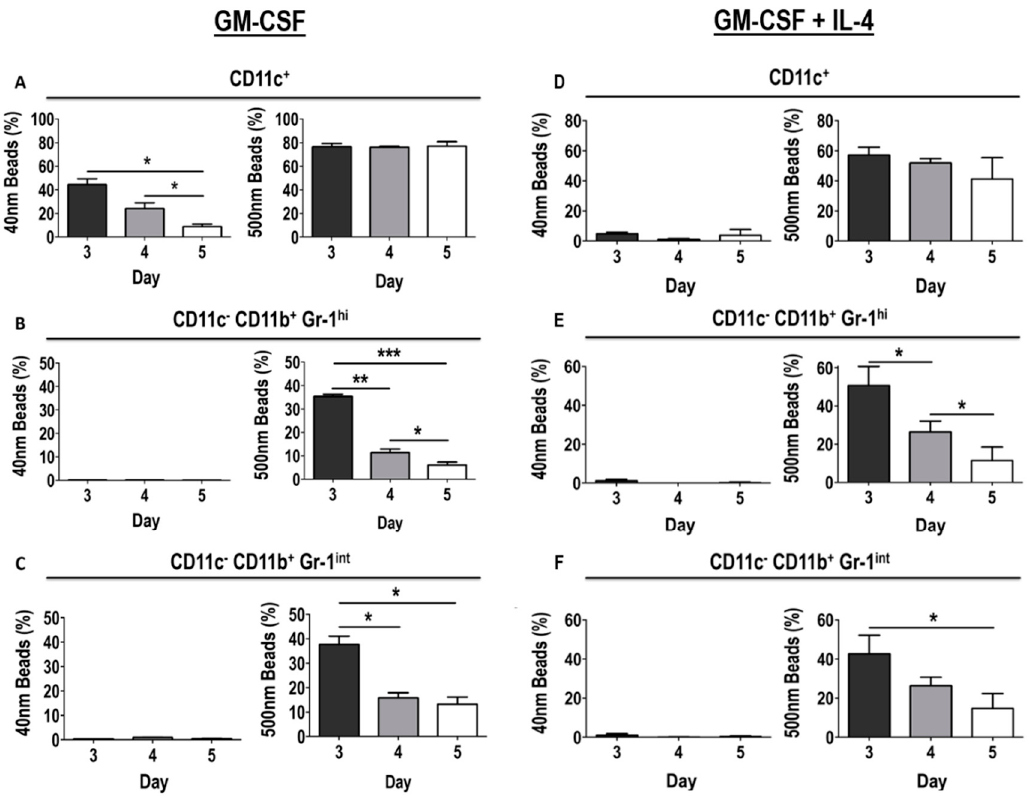
Figure 9. Di ff erential uptake capacity of DCs and MDSCs in early GM-CSF and GM-CSF + IL-4 derived cultures. Day 3, 4 and 5 GM-CSF and GM-CSF + IL-4 derived BM cultures were incubated with 40 nm or 500 nm particles for one hour at 37 degrees ◦ C in 5% humid CO 2 atmosphere. Cells were harvested on respective days and endocytic capacity was analyzed by flow cytometry for both 40 nm and 500 nm particle uptake by ( A , D ) DCs, ( B , E ) Gr-1 hi MDSCs and ( C , F ) Gr-1 int MDSCs. Results are shown from three mice. One-way ANOVA was used to calculate statistical significance. Results displayed as mean +/ − SD. * p < 0.05, ** p < 0.01, *** p <